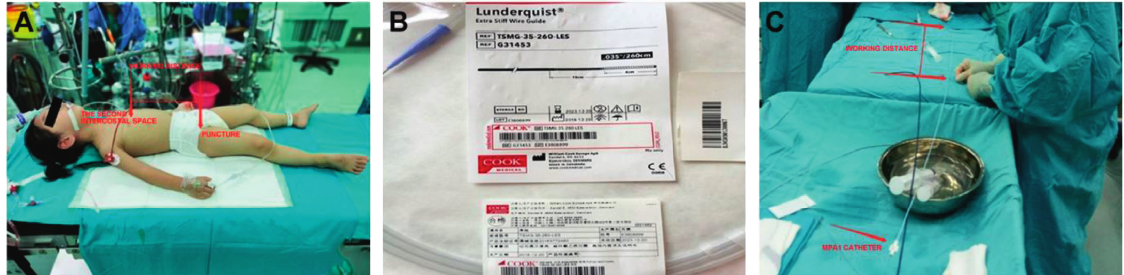
Figure 1: Measure the working distance: (a) the working distance is from the second intercostal space to the puncture site; (b) 0.035/260cm extra stiff wire guide; (c) the MPA1 catheter marks the working